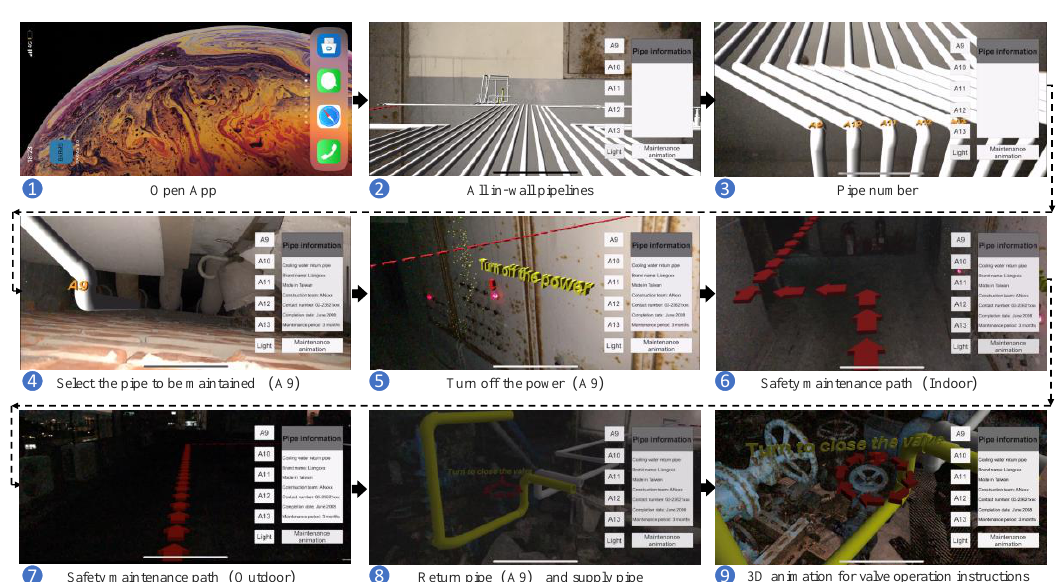
Figure 7. Smartphone screenshots of BARMS utilization.